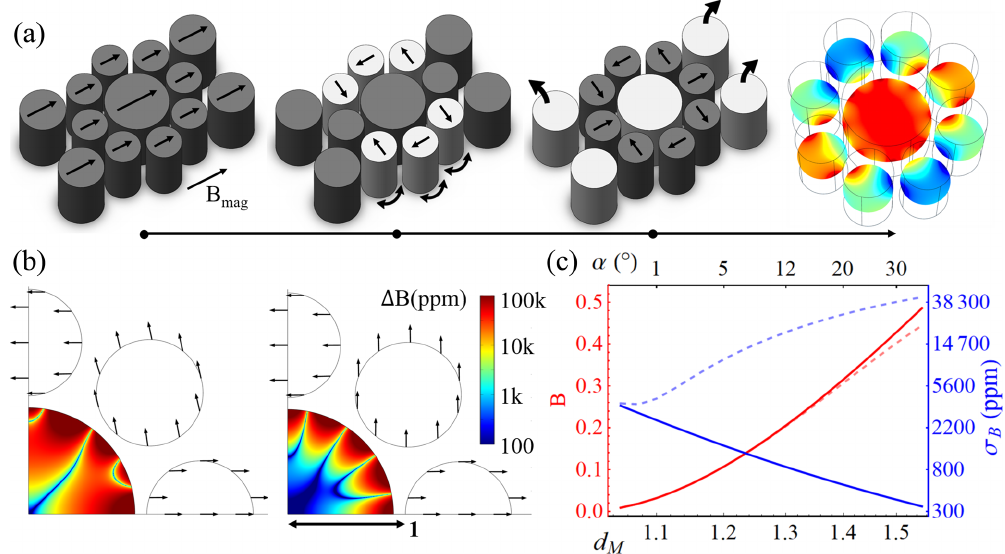
Figure 2. (a) The alignment process. Ferromagnetic thin film structures are deposited and magnetised uniformly along the lateral direction. Next, non-aligned structures are released from the substrate and allowed to rotate to their force equilibrium positions, after which they are fixed again to the substrate. Finally, correction structures are released and lifted off, leaving the final field distribution. Structures active in a step are shown brighter, and their magnetisation directions are indicated by straight arrows. Curved arrows indicate movement. The homogeneity of the procedure depicted in (a) is shown in panels (b, c) for the cases in which outer alignment structures are not (b) or are used (c) . The line plots in (c) reveal the standard deviation of the magnetic field, σ B (i.e. the homogeneity), as a function of the outer radius normalised to the design radius, d M , and the tilt angle α , for the self-alignments (dashed lines) and corrected alignments (full lines).